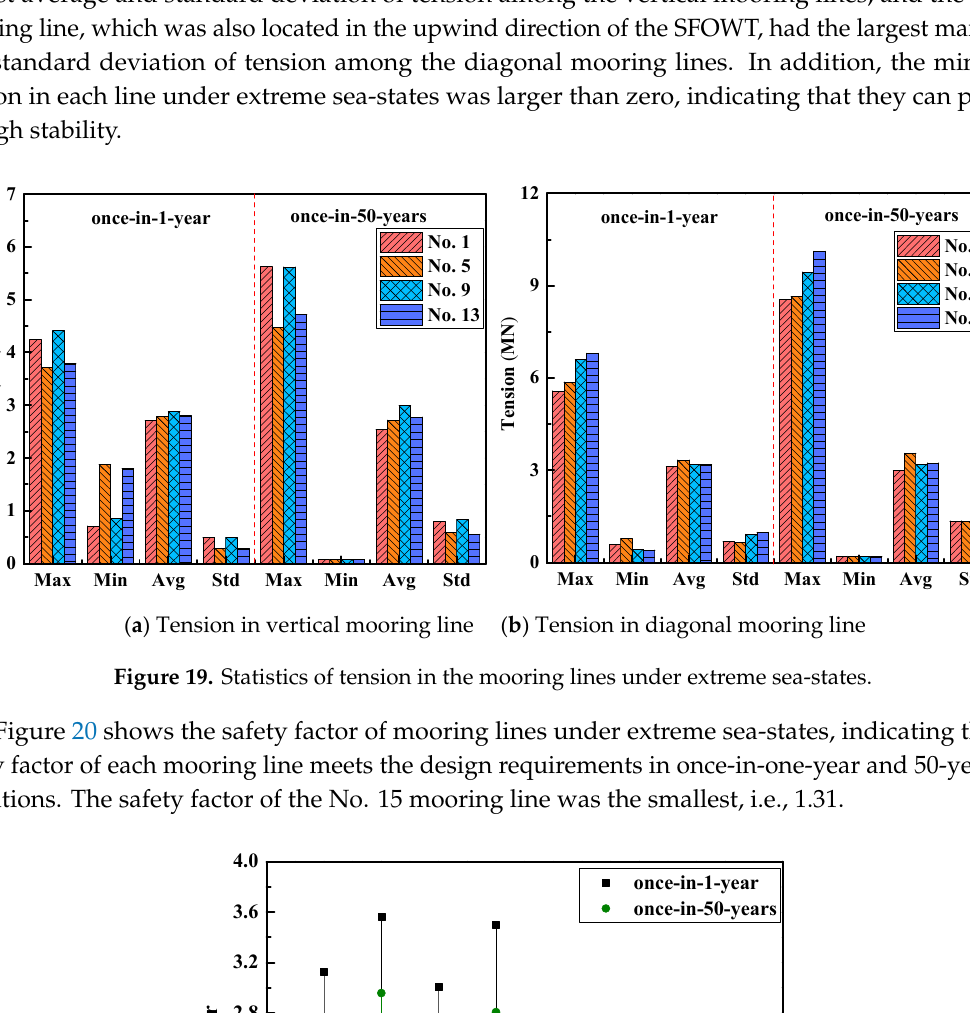
Figure 20. Safety factor of the mooring lines under extreme sea-states.